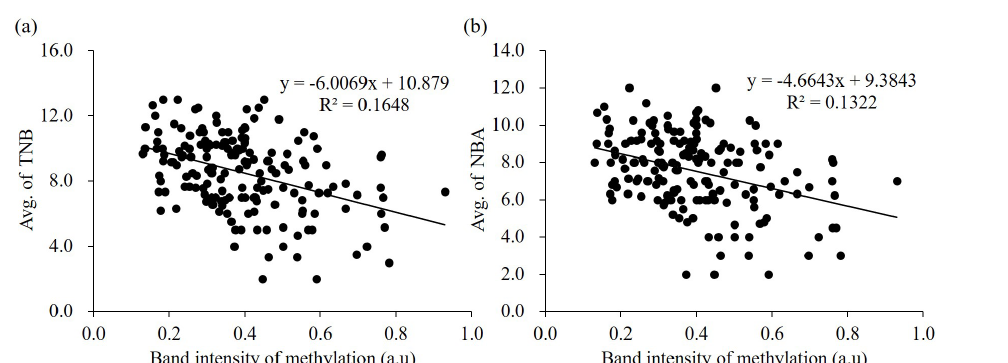
Figure 3. Correlation between methylation status of ZPBP gene and litter size traits (TNB and NBA) in 172 Berkshire sows using logistic regression analysis. The band intensities of PMP assay are shown on the x axis, and the y axis shows TNB (a) and NBA (b) . TNB: total number of piglets born; NBA: number of piglets born alive: a.u: arbitrary unit.